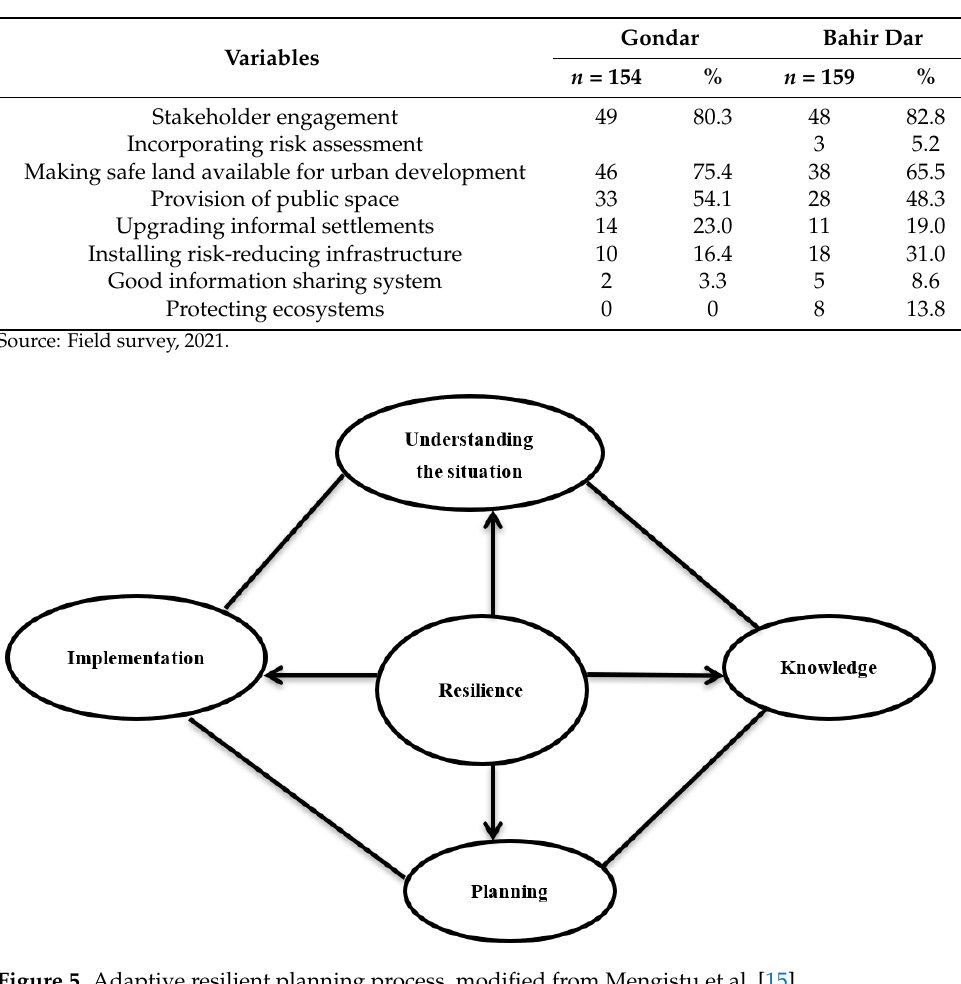
Table 5. UNISDR principles in achieving urban resilience in the study area (results based on multiple response rate).